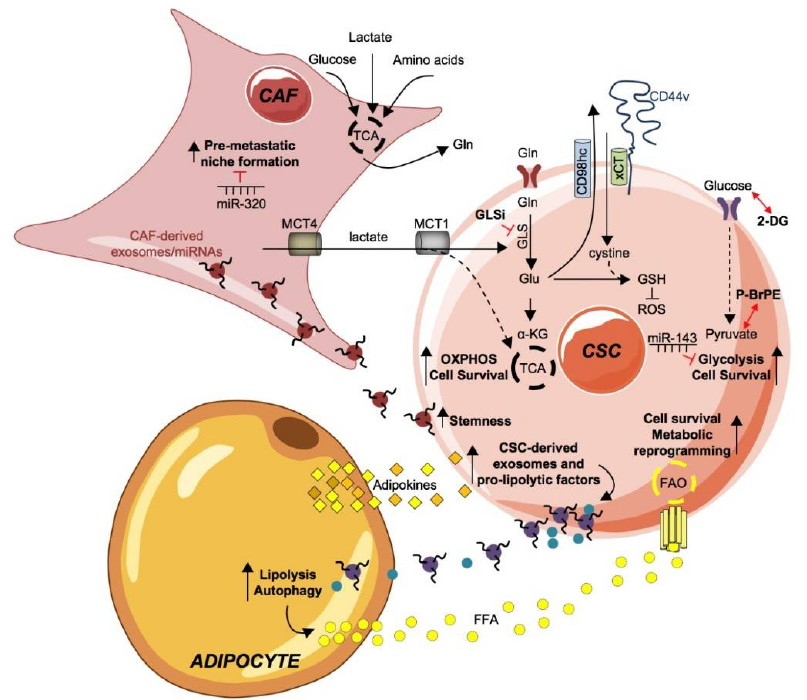
Figure 2. Metabolic fingerprint of cancer stem cells and their coupling with tumor microenvironment. The tumor microenvironment and every single part of it is an important element to be taken into consideration in tumor development. Through the production and excretion by the cancer associated fibroblast (CAF) of intermediate metabolites, such as lactate and glutamine (Gln), they are able to meet the continuous and demanding energy needs of CSCs. Gln is internalized by its transporter ASCT2 and converted in glutamate (Glu), by the enzyme glutaminase (GLS), finally inducing OXPHOS and cell survival of CSCs. GLS activity is blocked by GLU inhibitors. Glu contributes to the formation of reactive oxygen species (ROS) inhibitor molecule glutathione (GSH) by acting as an exchange ion, through the CD44v-xCT transporter, for the import of cystine, which is necessary for the production of GSH together with Glu. The uptake of glucose through the GLUT foster a glycolytic phenotype in CSCs boosting cell survival. The administration of the glycolysis inhibitors 2-deoxyglucose (2-DG), 3-bromopyruvate ester (pBr-PE) or miR-143 proved to effective in dampening the expansion of the CSC subpopulation.The crosstalk of CAF and CSC is possible through CAF-derived exosomes/miRNAs, including miR-21, miR-378e and miR-143. CAF-derived exosomes/miRNAs are internalized by CSC, sustaining stemness and positively influences tumor progression. Conversely, miR-320 counteracts pre-metastatic niche formation by CAFs.Adipocyte-secreted adipokines are taken upby CSC and stimulate the production and release of exosomes and pro-lipolytic factors, including miRNA-144 and miRNA-126, which in turn active lipolysis and autophagy pathways in adipocytes. Consequently, free fatty acids (FFA) are released in the tumor microenvironment (TME) that, upon absorption by CSCs through the fatty acid transporters (fatty acid translocase, FAT/CD36; fatty acid transport protein, FATP and fatty acid-binding protein, FABP), undergo fatty acid oxidation (FAO) to sustain CSCs expansion and metabolic reprogramming.